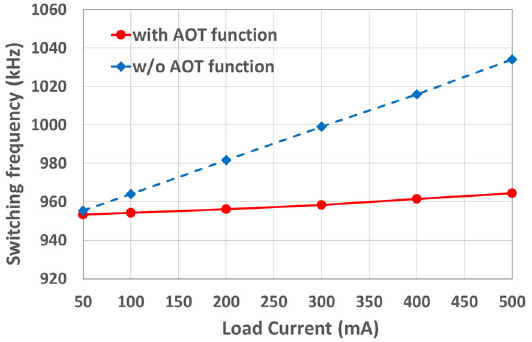
Figure 16. Switching frequency versus different load currents with and without AOT function.